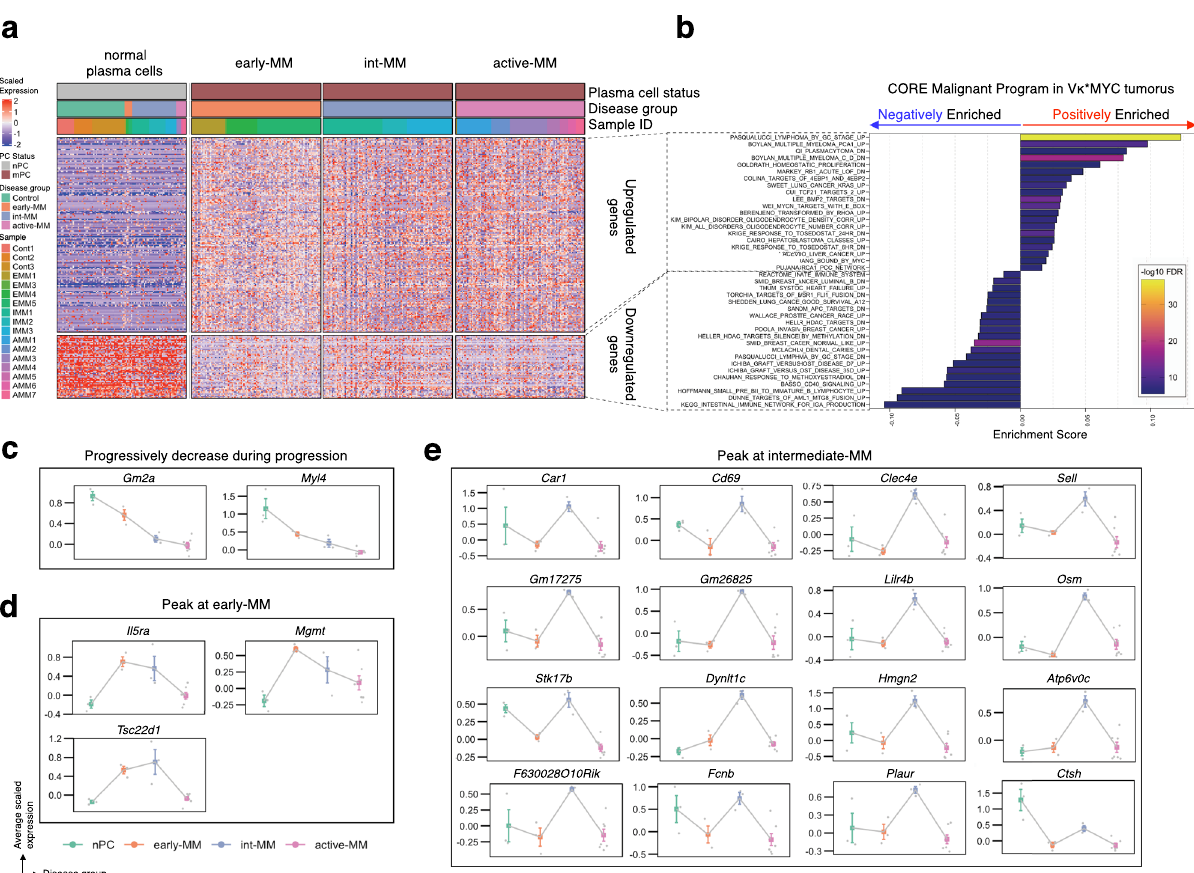
Fig. 2 Core versus disease-stage speci fi c gene expression programs in malignant cells from V κ *MYC mice. a Heatmap of differentially expressed genes shared by all malignant cells in V κ *MYC mice compared to normal plasma cells (FDR < 0.05). Heatmap is split vertically to show normal plasma cells (nPC) versus malignant plasma cells (mPC), the latter of which is further split by disease stage group. The upper and lower panels of the heatmap separate upregulated and downregulated genes, respectively. A subset of 100 randomly selected cells per disease stage group are shown and data represent scaled expression values (any values outside a range of − 2 to 2 were clipped). b Top 20 positively/negatively enriched terms from MSigDB gene set enrichment analysis (H, C2, C6, FDR < 0.05) computed using core upregulated/downregulated genes identi fi ed by DE analysis in ( a ). c – e Disease stage-speci fi c genes that are signi fi cantly differentially expressed between disease stage groups. Coloured dots represent the mean expression of disease stage samples for each gene, with error bars depicting the standard error of the mean. Statistical comparisons were performed using a two-sided t-test with subsequent correction for multiple testing (Bonferroni). Grey data points represent mean expression of respective genes in cells from each biologically-independent animal (Cont1 = 44 cells, Cont2 = 72 cells, Cont3 = 148 cells, EMM1 = 45 cells, EMM4 = 52 cells, EMM5 = 71 cells, IMM1 = 206 cells, IMM2 = 88 cells, IMM3 = 149 cells, AMM1 = 2,003 cells, AMM2 = 830 cells, AMM3 = 1,379 cells, AMM4 = 822 cells, AMM5 = 302 cells, AMM6 = 323 cells, AMM7 = 310 cells). Genes are grouped according to the pattern of expression throughout progression. Source data are provided in SourceData_Fig.